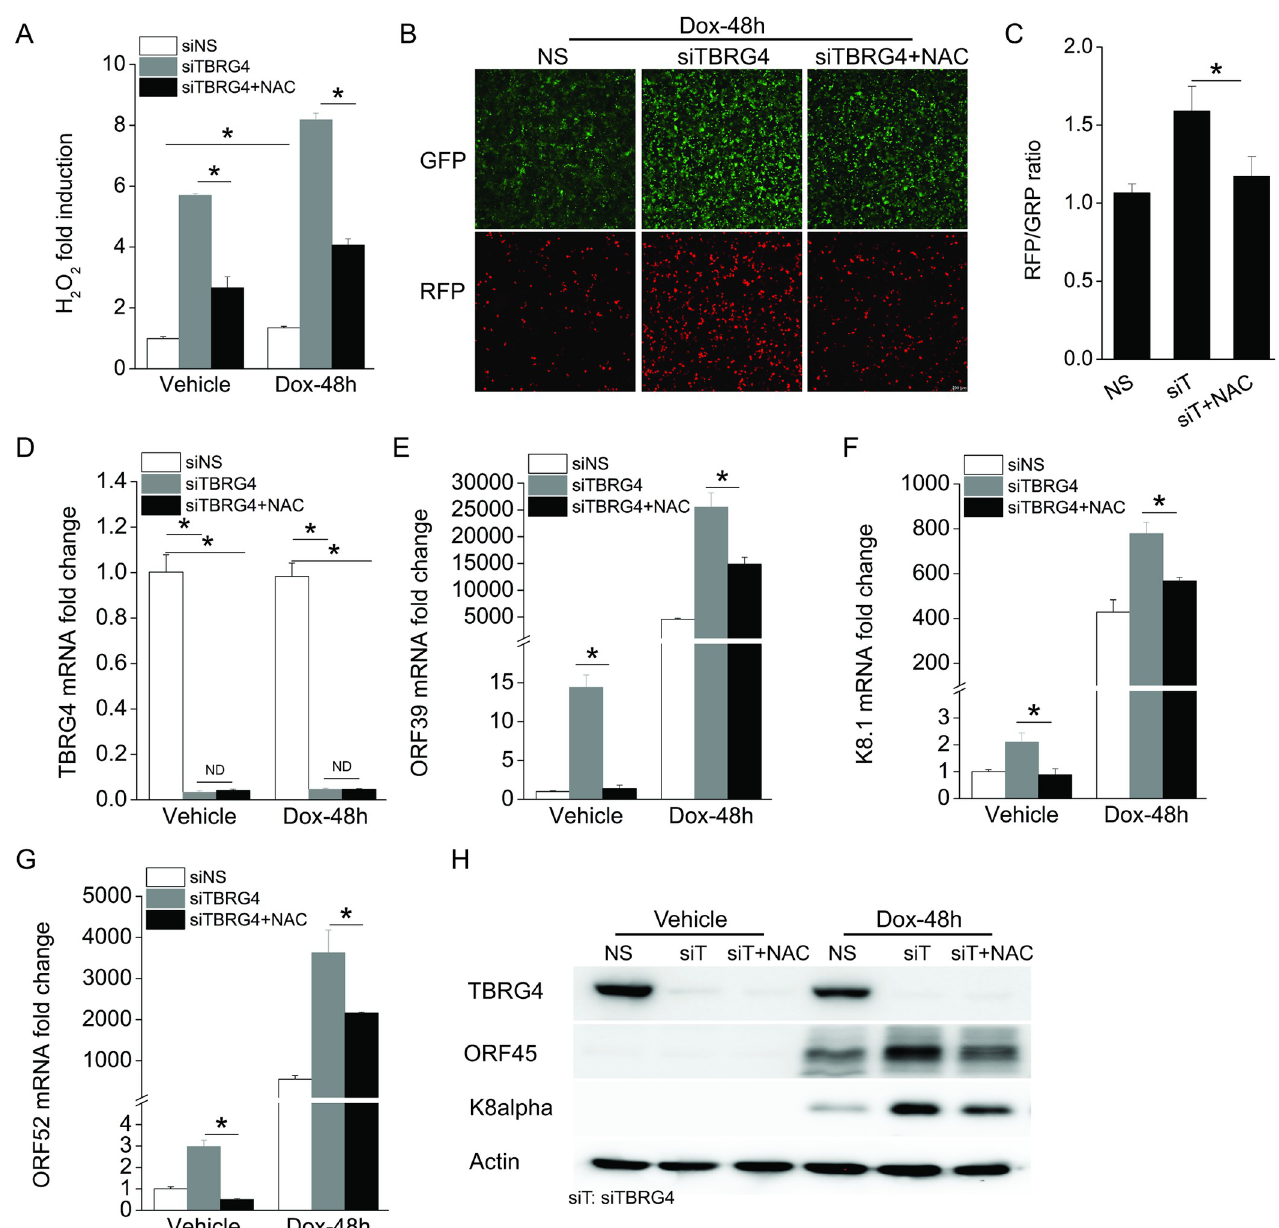
Fig 5. A ROS scavenger affects KSHV lytic reactivation from latency in TBRG4-depleted cells. iSLK.219 cells were transfected with NS, siTBRG4 or siTBRG4 along with 2 mM NAC for 48 h and then treated with Dox for 48 h. (A) The level of H 2 O 2 was measured with ROS-Glo H 2 O 2 assay. H 2 O 2 substrate was added for 5 h and luminescence signal was measured and presented as fold induction. (B) GFP- and RFP- positive cells were imaged at 48 h post-Dox treatment. (C) GFP and RFP intensities were measured using a Clariostar plate reader, and the RFP/GFP ratio was calculated at 48 hours post-Dox treatment. (D-G) The mRNA expression of TBRG4, ORF39, K8.1 and ORF52 was measured by real-time PCR. (H) Western blots were performed with the indicated